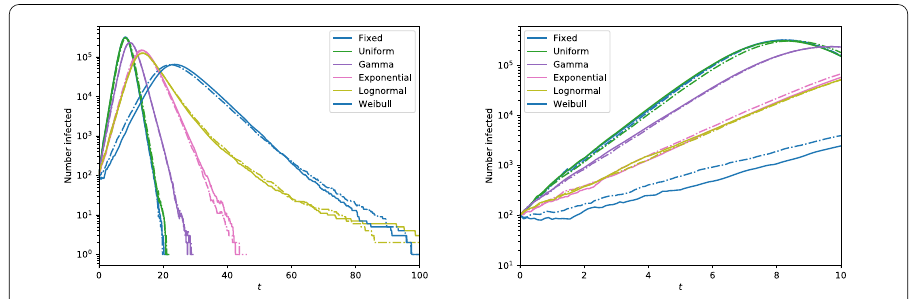
Figure 4 Dynamics of epidemics in Erd˝os–Rényi network. Taking τ = 0.15, we show two epidemic curves for each distribution from Fig. 3. On the right we see the early dynamics